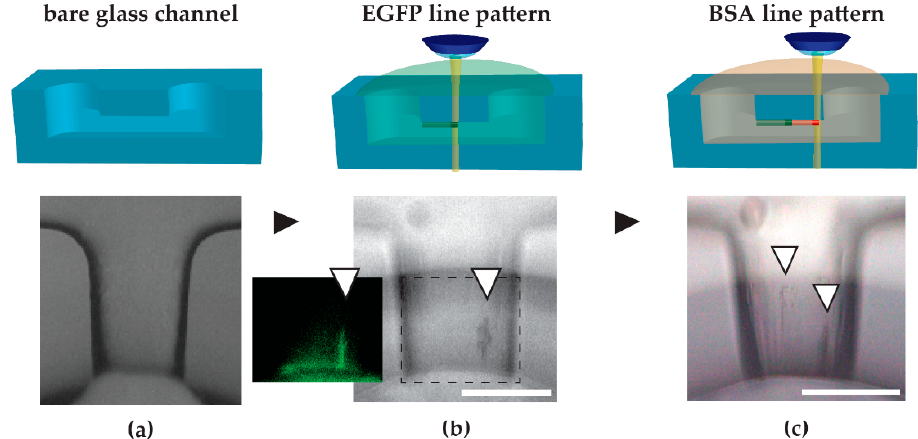
Figure 3. Multi-protein line pattern of enhanced green fluorescent protein (EGFP) and consecutive BSA inside a glass microchannel with a 200 - kHz laser. Schematic drawing and top view bright field microscopy image. Black arrows indicate work-flow, white arrows highlight pattern. ( a ) A bare glass microchannel. ( b ) As a first step, the channel was filled with EGFP solution and a line was polymerized near the inlet with 6.4 mW and 2 μ m/s. The dashed area was imaged by a fluorescence microscopic unit with an excitation of 450–480 nm and emission of 520–800 nm. The inset fluorescence image confirmed the EGFP line to be fluorescent. ( c ) In continuation, the sample was filled with BSA solution and a second line pattern was polymerized with 6.4 mW and 200 nm/s. Scale bars represent 100 μ m.